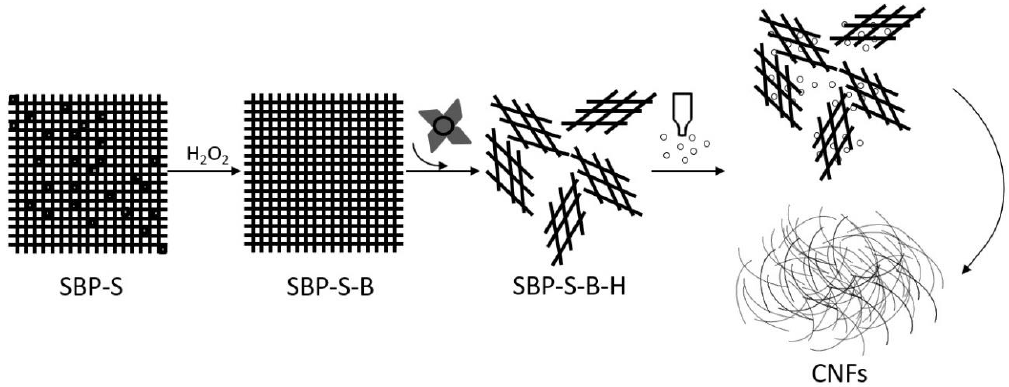
Figure 6. Mechanism of steam explosion, bleaching, high-speed blending and ultrasonic treatment for the extraction of CNFs.